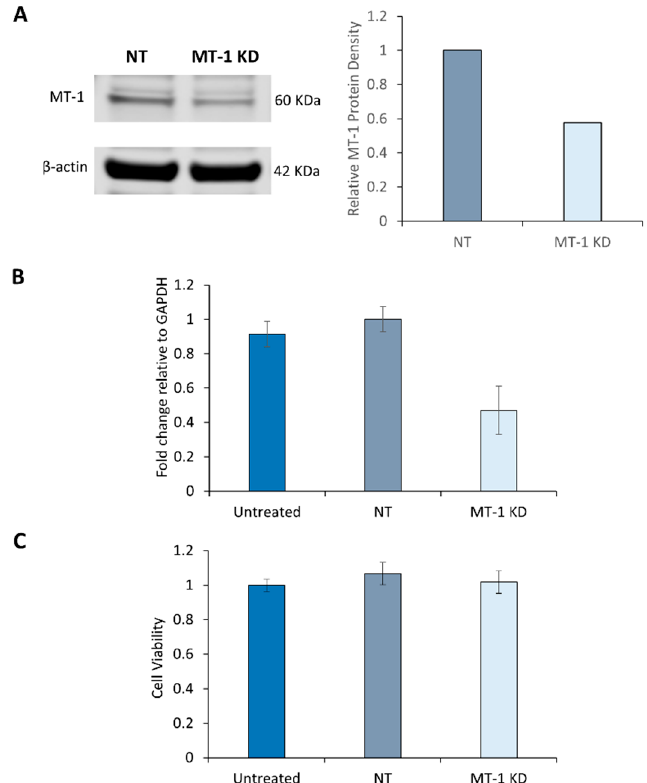
Figure 3. Knockdown of MT-1 receptor. ( A ) Young NHDF were electroporated with MT-1 receptor specific siRNA. Protein levels were measured by Western blot 72 h post-electroporation and ( B ) mRNA levels by RT-PCR 48 h post-electroporation. NHDF were electroporated with non-targeting (NT) siRNA for comparison. ( C ) The viability of electroporated NHDF was compared with the untreated cells and assessed by Alamar Blue staining. Error bars are SEM. N = 4.